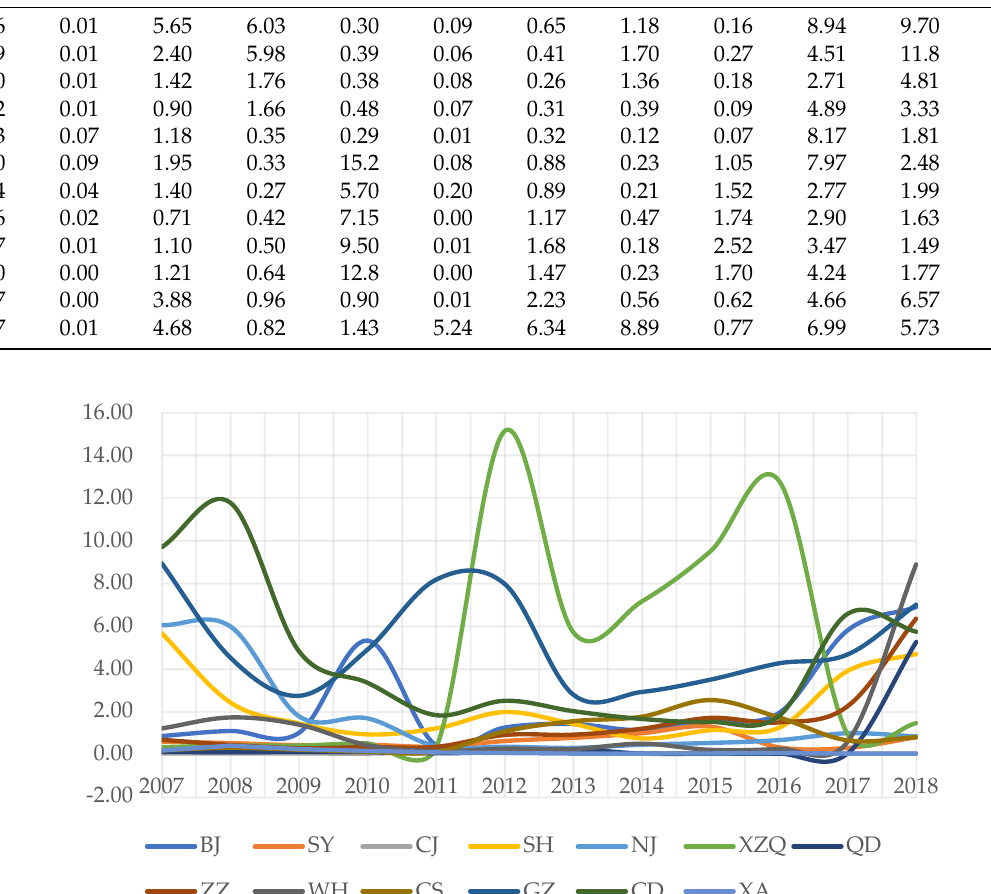
Figure 5. Variance indexes of ECILUs in the metropolitan areas 2007-2018.